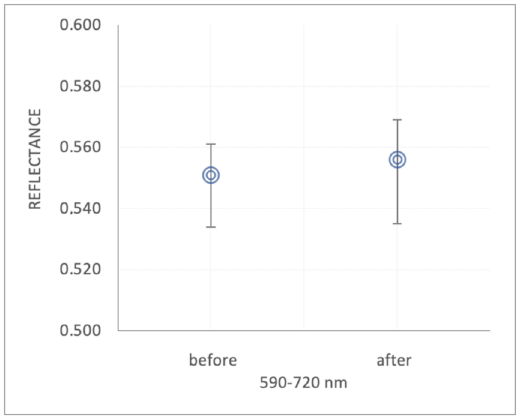
Figure 7. Average results of 3 reflectance measurements at a wavelength of 590–720 nm in every woman undergoing microdermabrasion, before and after the procedure.